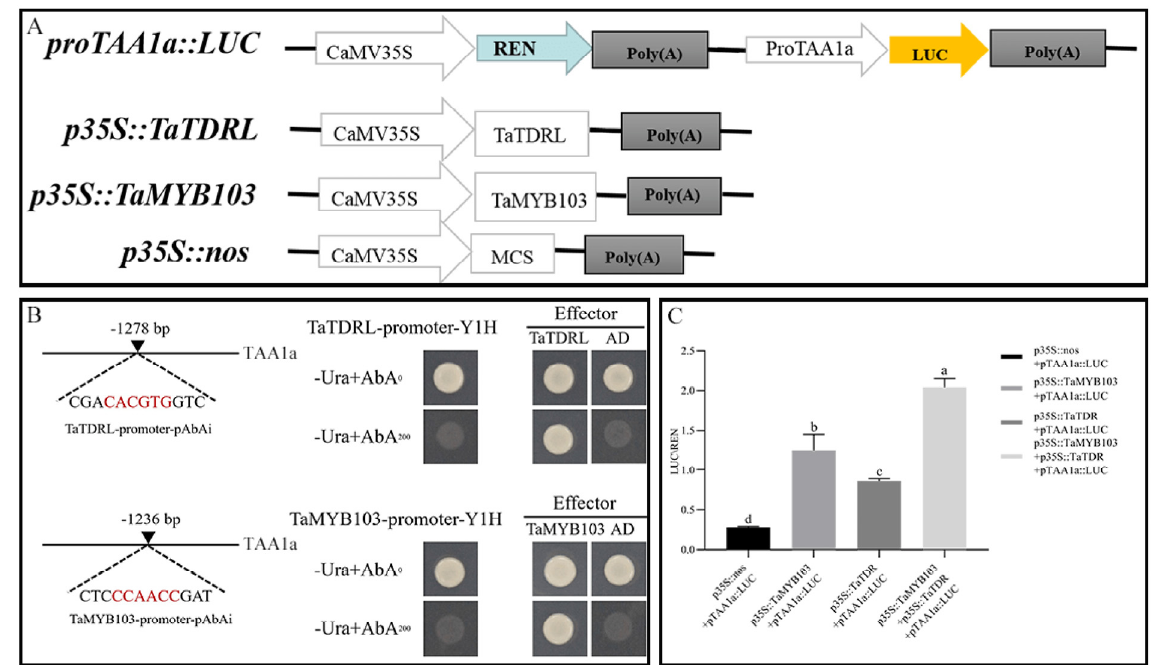
Figure 4. Co-regulation of proTAA1a by TaTDRL and TaMYB103. ( A ) Constructs used in the dual- luciferase assay. ( B ) Analysis of the interaction between TaTDRL or TaMYB103 and the TAA1a promoter using a yeast one-hybrid assay. ( C ) Transient dual-luciferase assays were performed in the Nicotiana benthamiana leaf. The activities of firefly luciferase (LUC) and Renilla luciferase (REN) were sequentially measured and the LUC/REN ratio was calculated as the final transcriptional activation activity. Data represent the means ± standard deviation of three biological replicates. Different lower-case letters indicate significant differences at p < 0.05.